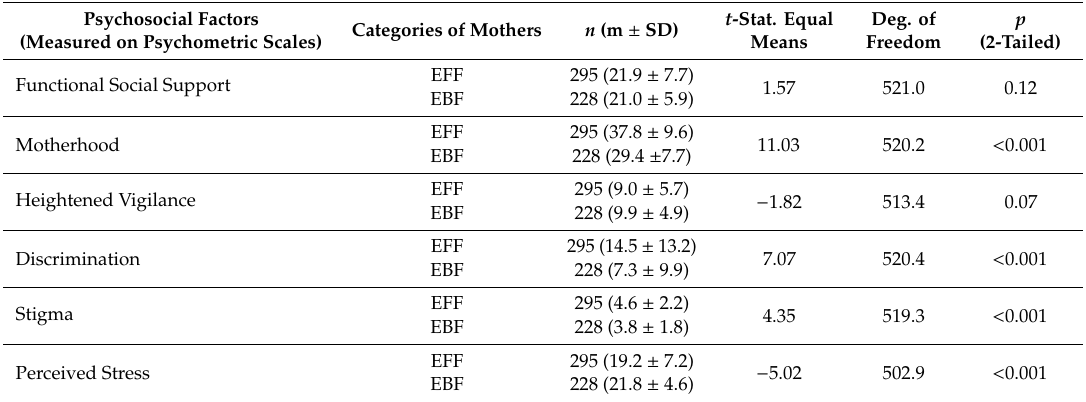
Table 2. Comparison of psychosocial factors in mothers practicing exclusive formula feeding and those practicing exclusive